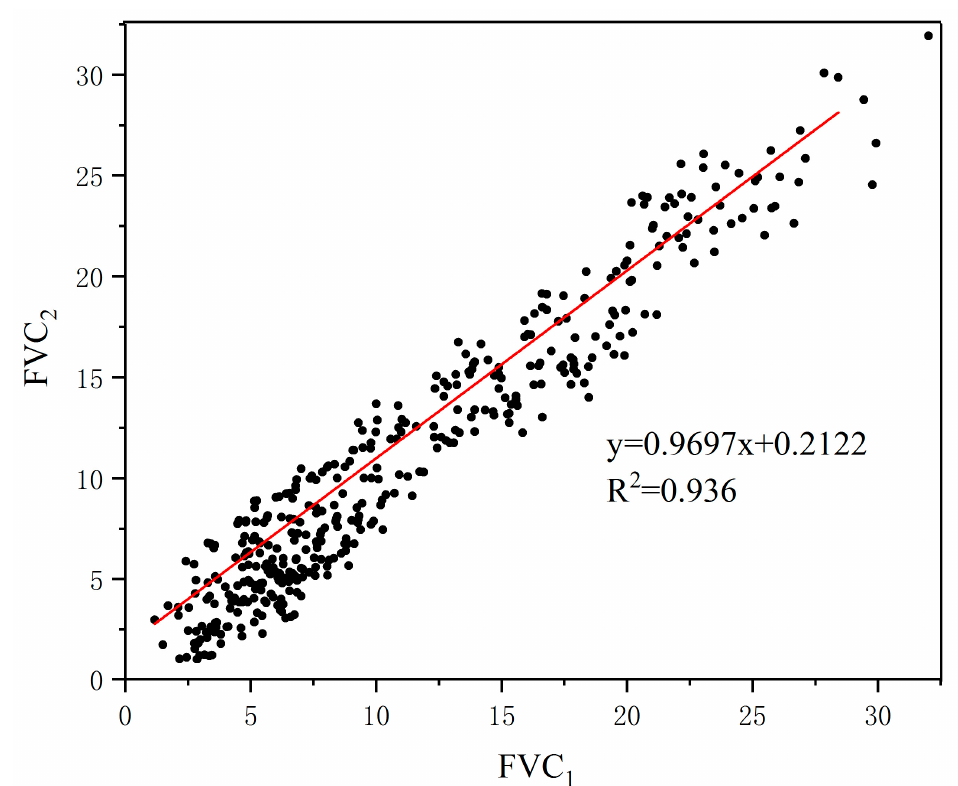
Figure 6. Comparison of the FVCs of the quadrat extracted by the different person (FVC 1 and FVC 2 represent the FVC data obtained by different people, respectively).